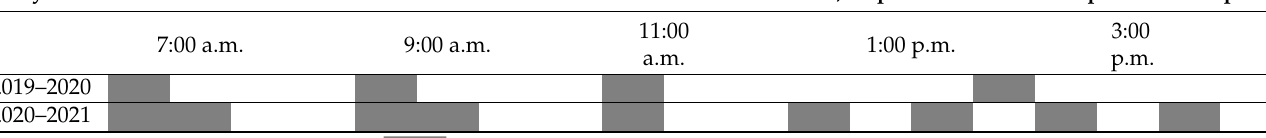
Table 6. Average sample of ventilation in kindergartens in the 2019/20 measuring period (buildings 1–3, building no.4 has forced ventilation) before the pandemic and in 2020–2021 (buildings 1–4) during the COVID-19 pandemic. Daily Timeline—Arrival of Children to the Classroom between 6:00 a.m. and 7:00 a.m., Departure between 3:00 p.m. and 3.30 p.m.